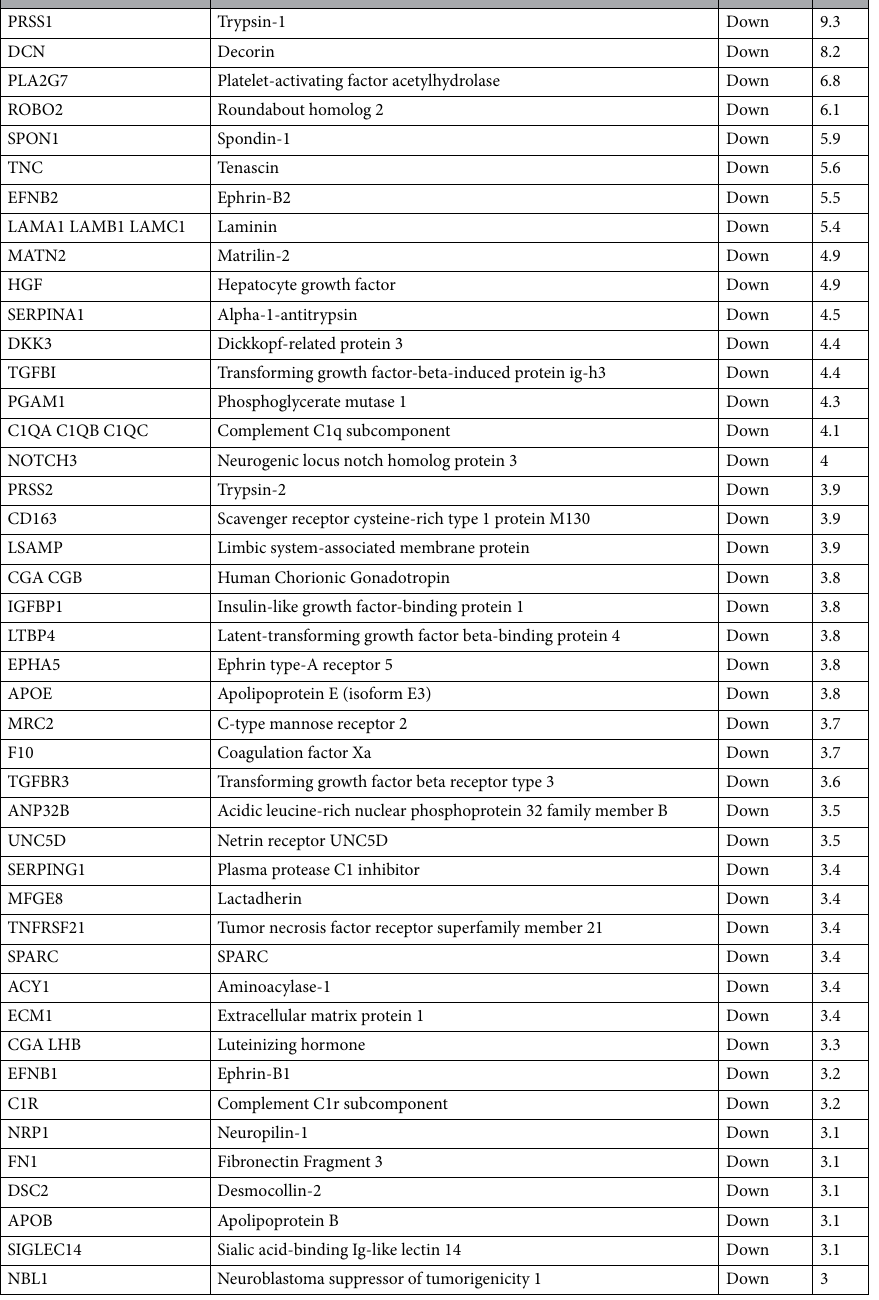
Table 2. List of the top 100 amniotic fluid proteins that significantly change in abundance between gestational-age groups in normal pregnancy. The table consists of the gene symbol, protein name, direction of change, and fold change (Term not in labor vs.